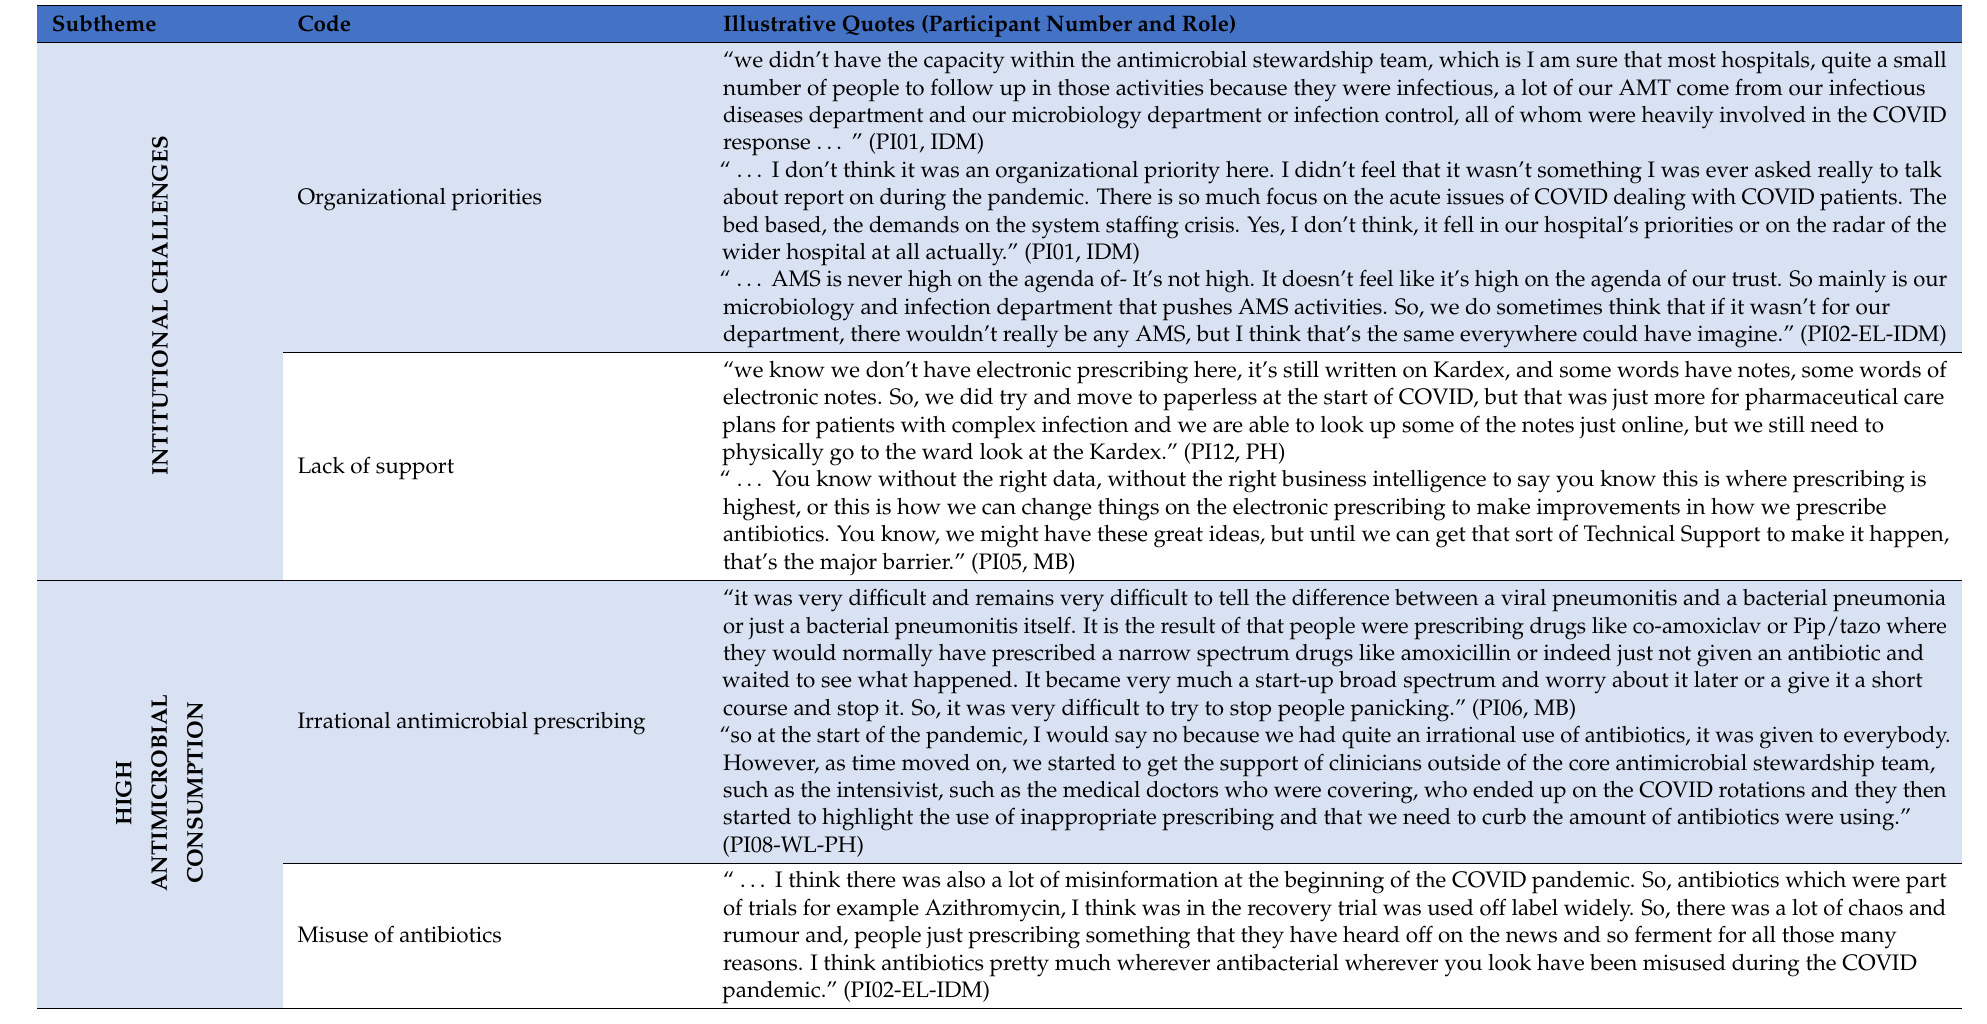
Table 3. THEME TWO: Challenges to implementing AMS activities before and during the